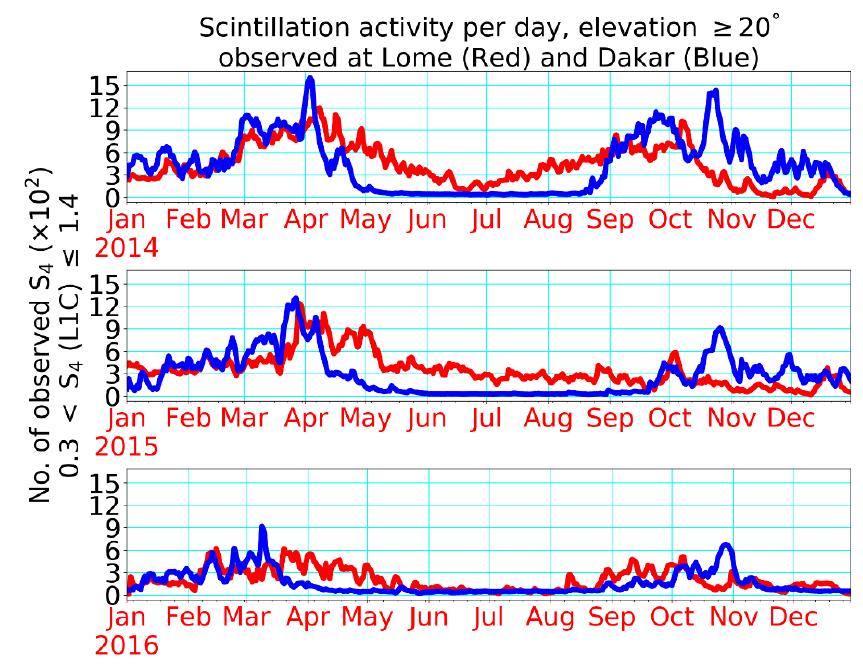
Figure 3. Number of scintillation events recorded with a 50 Hz receiver in Lomé (red) and Dakar (blue) during 2014, 2015 and 2016,